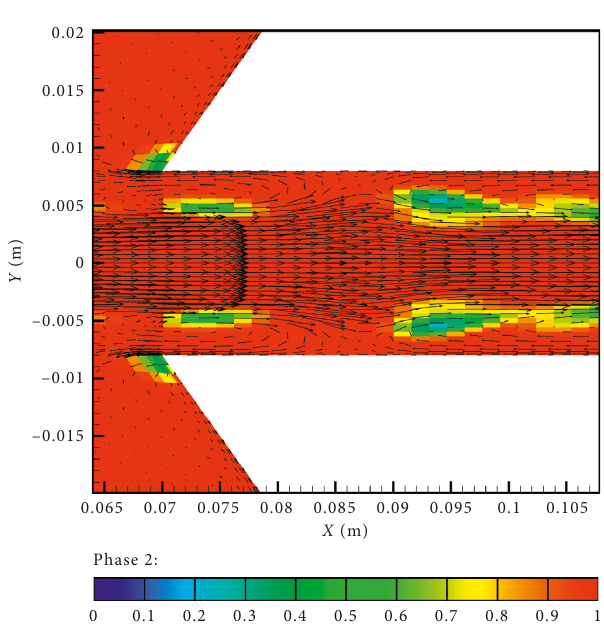
Figure 13: Vector diagram of downstream nozzle outlet.